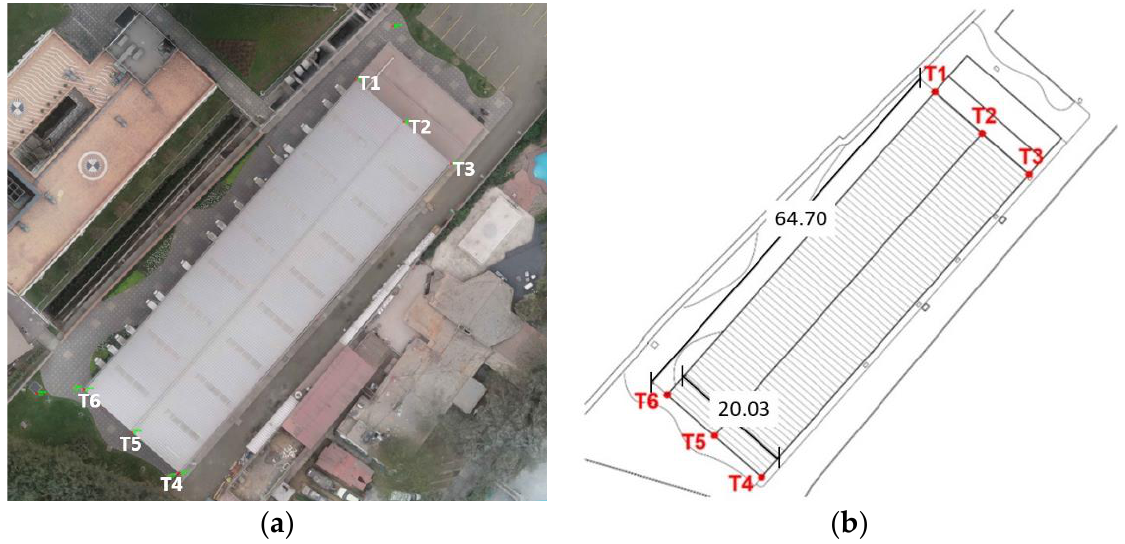
Figure 19. Control points for validation. ( a ) Area points in orthophoto; ( b ) Area points in plan.